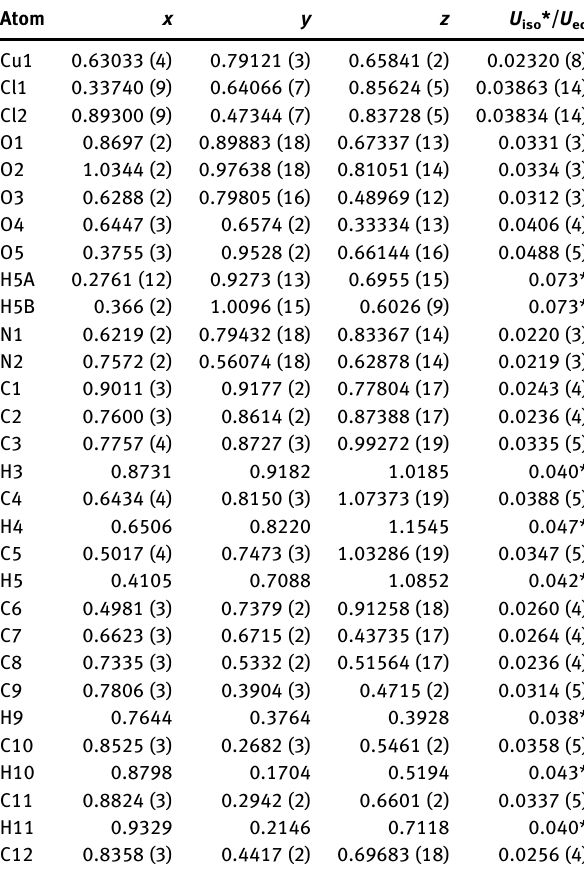
Table  : Fractional atomic coordinates and isotropic or equivalent isotropic displacement parameters (Å 